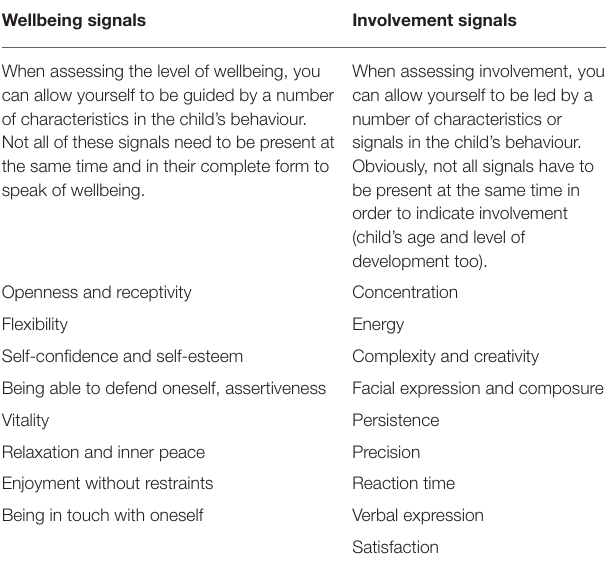
TABLE 1 | Wellbeing and involvement